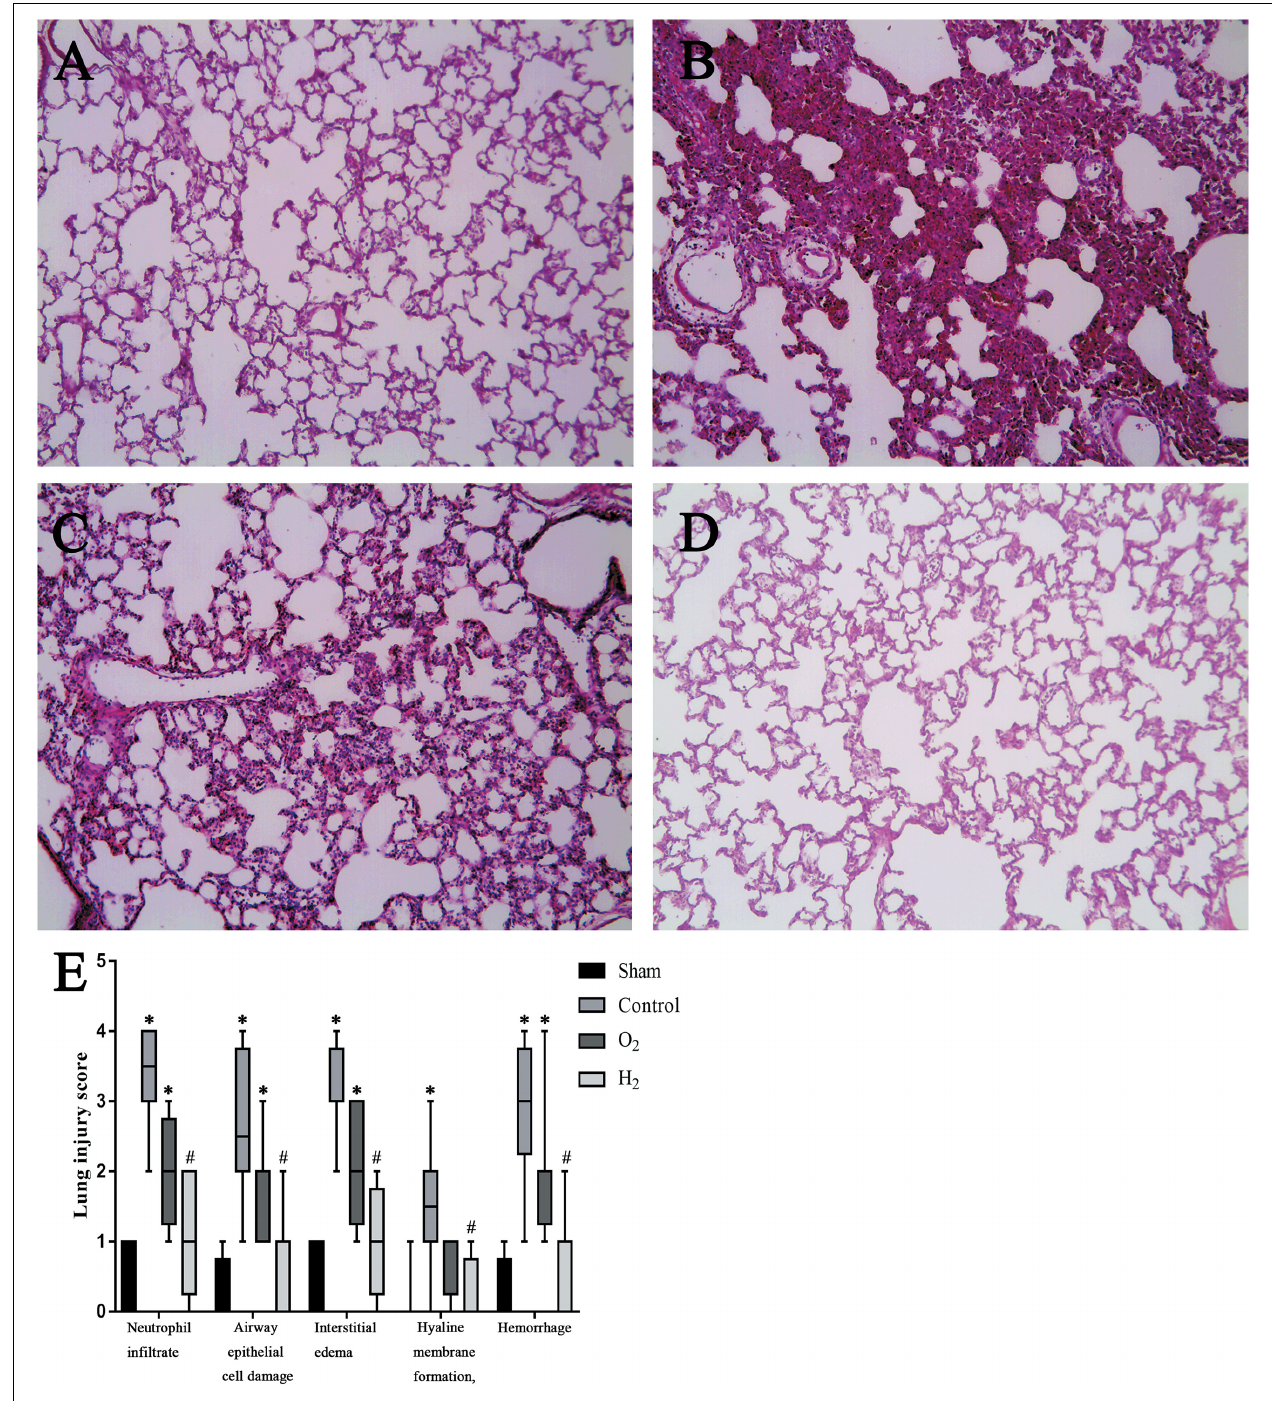
FIGURE 5 | Histologic analyses of lung grafts ( n = 8, original magnification, 40). (A) sham group; (B) control group; (C) O 2 group; (D) H 2 group; (E) Lung injury score (LIS). The LIS in the control group was higher than the sham group ( P < 0.05), the H 2 group was lower than the control group ( P < 0.05). ∗ P < 0.05 vs. sham group; # P < 0.05 vs. control group; (cid:77) P < 0.05 vs. O 2 group.